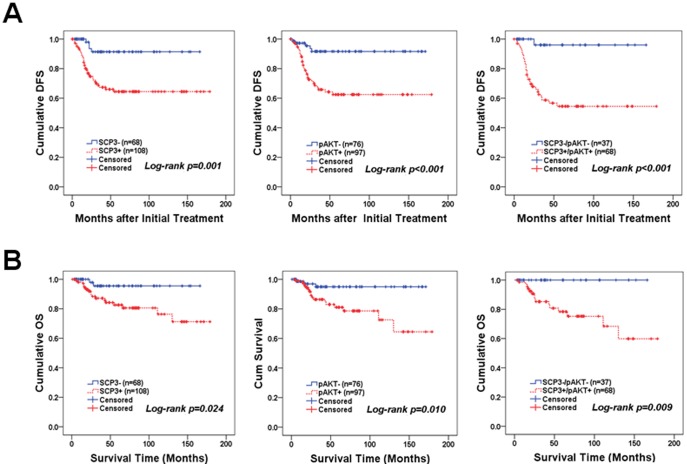
Kaplan-Meier plots for disease-free survival (A) and overall survival (B) according to SCP3 expression, combined SCP3 and pAKT expression, and pAKT expression alone.For patients with high SCP3 expression, the mean disease-free survival and overall survival were 122.4 months and 144.8 months (n = 108), respectively. For patients with low SCP3 expression, mean disease-free survival and overall survival were 153.5 months and 159.6 months (n = 68), respectively.